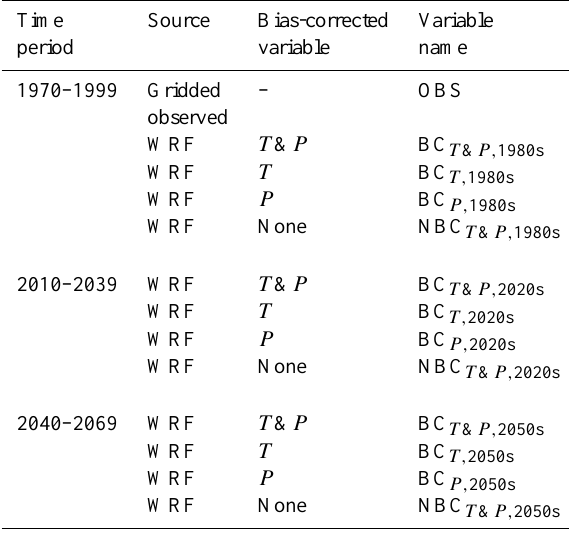
Table 1. List of climate scenarios for this study. All WRF sim- ulations used as boundary conditions results from the